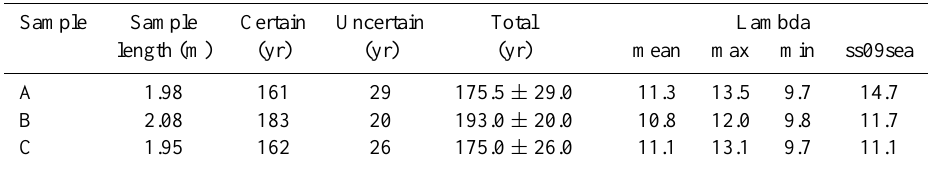
Table 3. Annual layer thicknesses (lambda) derived from the measured sections based on annual layer counting. The number of “certain” and “uncertain” annual layers results in total annual layers and error estimate. Lambdas of the modeled time scale ss09sea are shown for